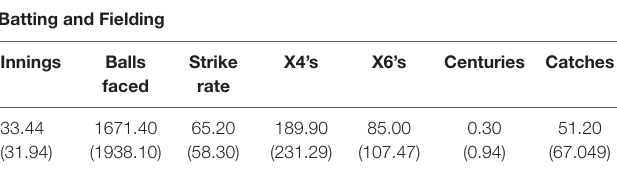
TABLE 2 | Average (SD) batting and fielding performance statistics. Batting and